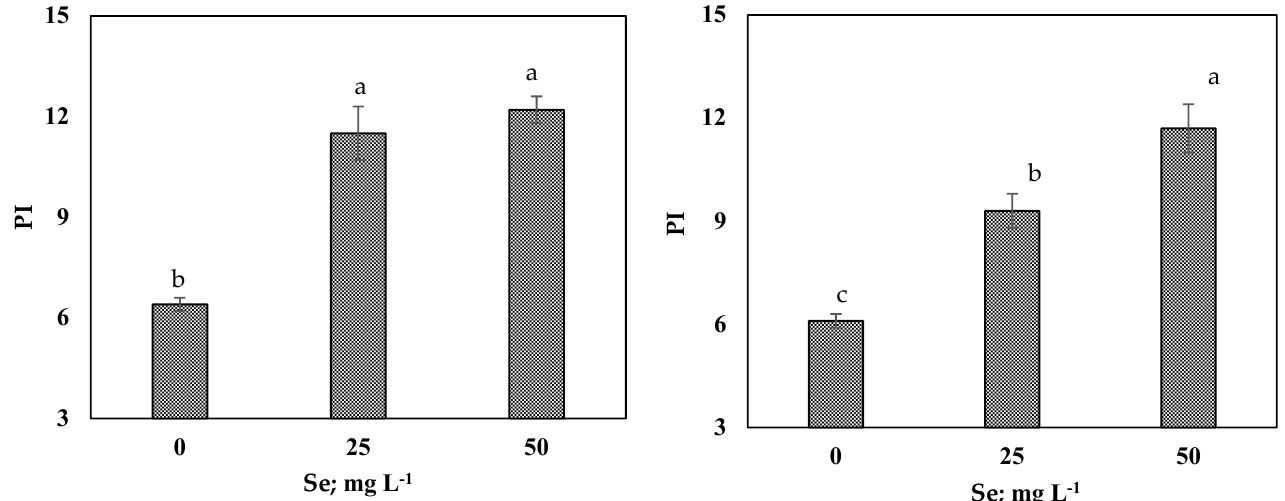
Figure 1. Effects of selenium (Se; mg L − 1 ) foliar applications on Chlorophyll a fluorescence i.e., ( F v /F m and F v /F 0 ) and photosynthetic performance index (PI) of onion under saline soil (EC = 5.2 dS m − 1 ) conditions in S I and S II seasons. Vertical bars represent means ± S.E ( p ≤ 0.05). Columns marked by different letters are significantly different.